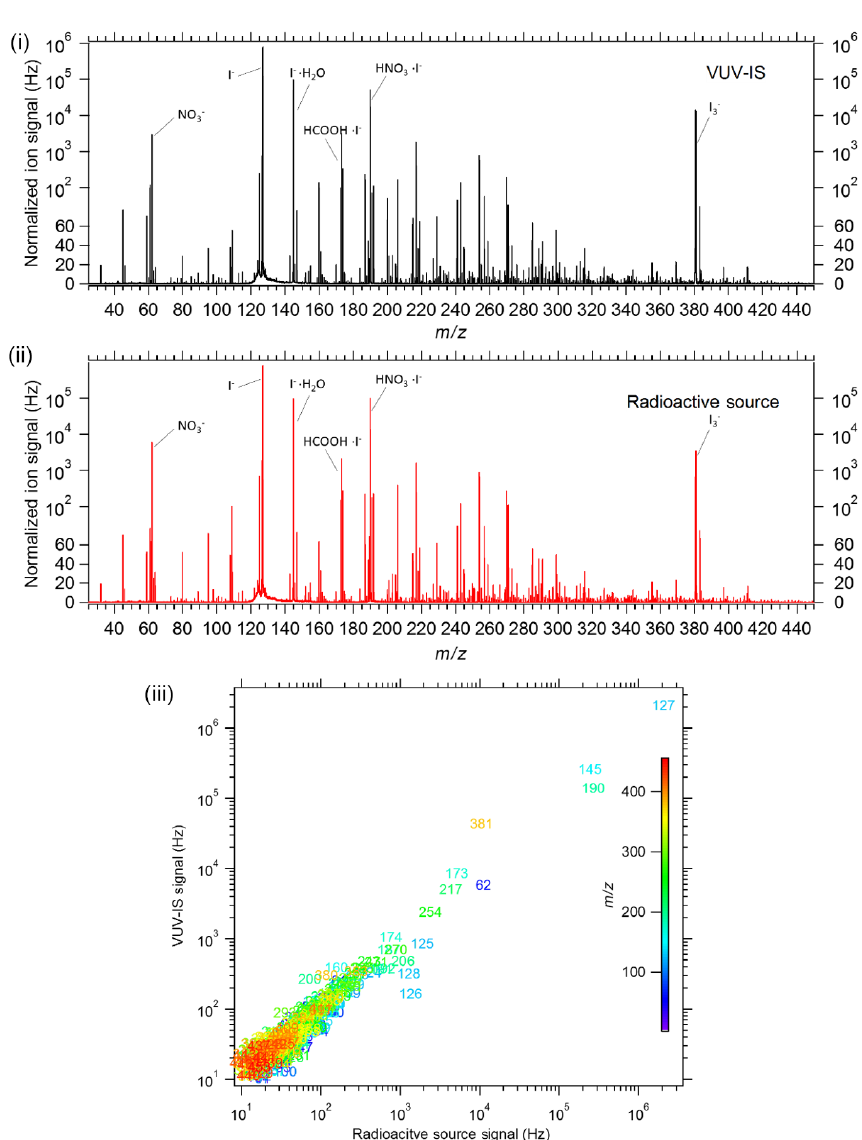
Figure 8. Mass spectra of ambient air in Boulder, Colorado, from a TOF-CIMS with (i) a VUV-IS and (ii) a radioactive source. The bottom panel (iii) is a correlation plot of the individual mass signals with the VUV-IS versus those obtained with a radioactive source, with each ion labeled by its nominal